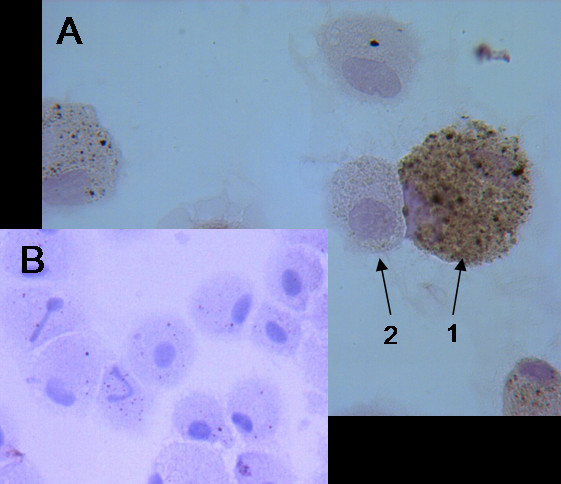
MMP-12 expression in BAL. Representative photomicrograph (original magnification: ×1000) of BAL cells immunocytochemical staining for MMP-12 (brown cytoplasm). 1 – MMP-12+-macrophage, 2 – MMP-12--macrophage. A – positive control, B – negative control (rabbit IgG).